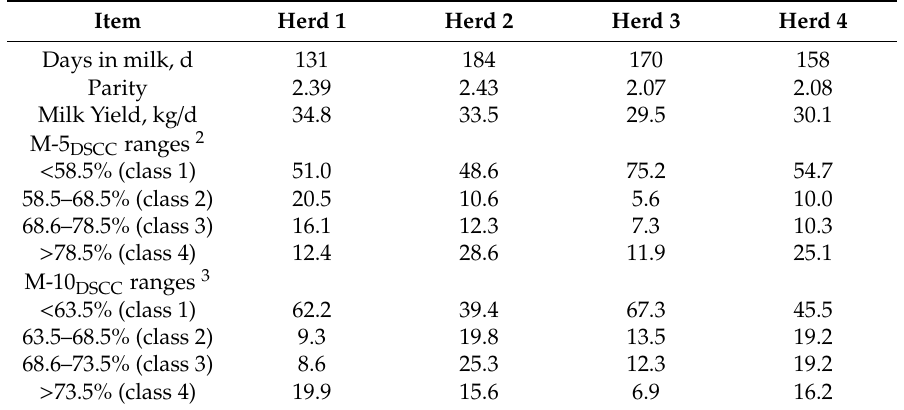
Table 1. Mean values 1 of days in milk, parity and daily milk yield for individual cows and frequencies for each class of Di ff erential Somatic Cell Count (DSCC) of M-5 DSCC and M-10 DSCC of milk samples collected during the experimental trial among herds. Item Herd